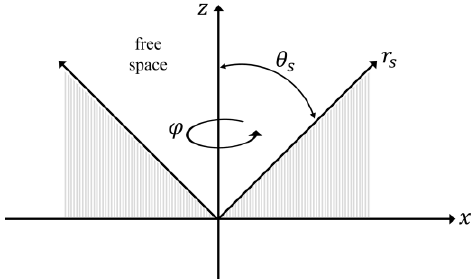
Figure 1. Geometry for expansion of spherical waves within a cone of polar angle 𝜃 𝑠 , and with the surface of the cone being an active source capable of generating spatial distributions in the form of spherical Bessel functions and sums of spherical Bessel functions. The azimuthal angle is 𝜑 , the radial coordinate 𝑟 𝑠 lies on the active source, and z represents the zenith direction.